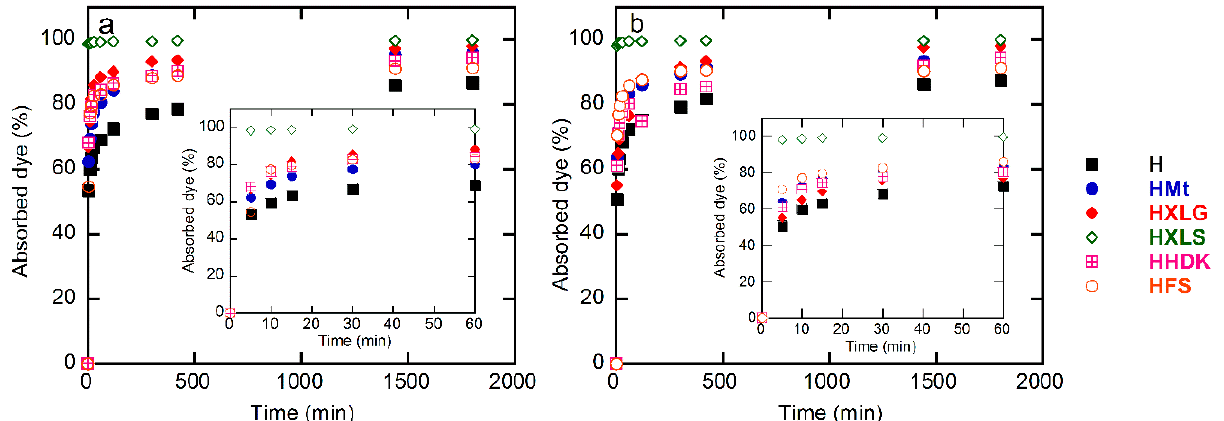
Figure 8. Time dependence of the percentage of dye absorbed by the (nano)composite hydrogels: ( a ) methylene blue; ( b ) crystal violet. Initial dye concentration = 20 mg/L; xerogel amount = 0.003 g; dye solution volume = 30 mL; temperature = 25 ± 0.5 °C.